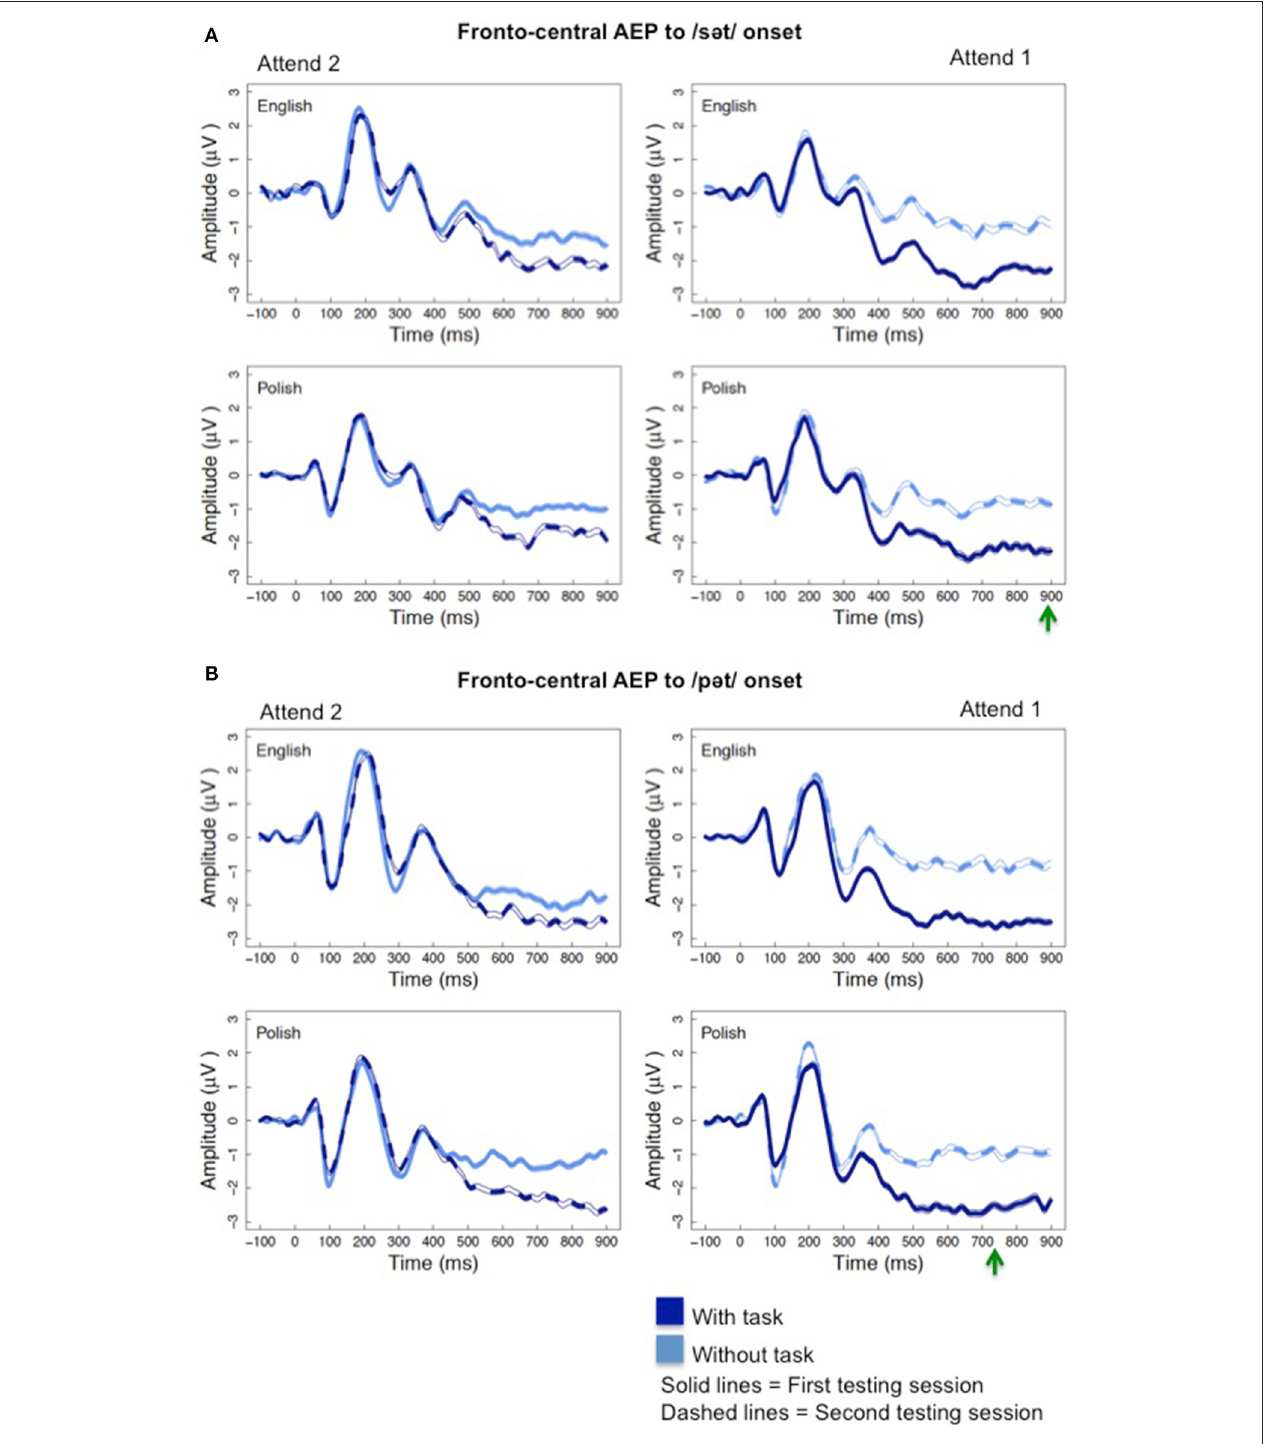
FIGURE 2 | The effect of attention on the fronto-central AEP (A) to the /set/ onset and (B) the /pet/ onset. Notice the negative-going deflection for the “with task” conditions (dark blue, solid and dotted lines) relative to the “without task” conditions (light blue, solid and dotted lines) that was more pronounced when the “with task” condition occurred during the first testing session (dark blue, solid lines) within the “Attend 1” sequence of condition presentation (right). The green arrows depict the earliest possible appearance for the second word in the word pairs.